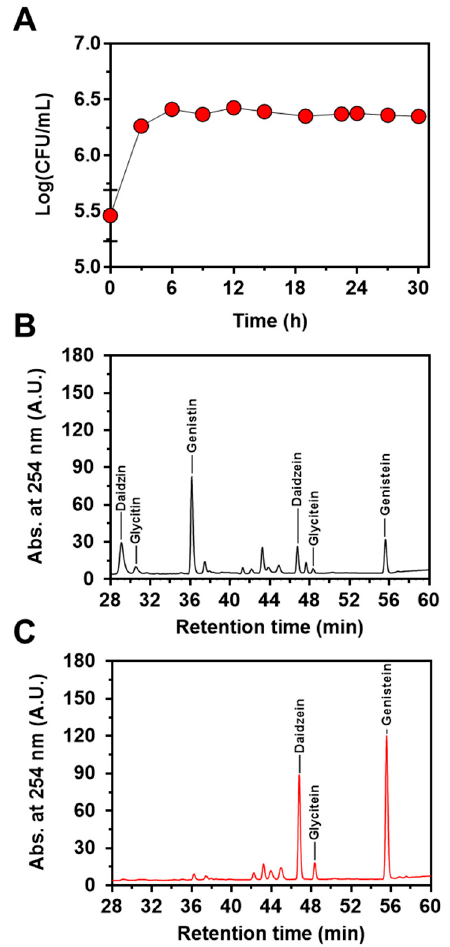
Figure 5. Soymilk fermentation of L. citreum harboring pCB4270V4-IH. ( A ) Growth profiles of L. citreum harboring pCB4270V4-IH. Results are the mean of duplicate experiments, and error bars indicate standard deviations. Chromatogram of HPLC analysis of isoflavones in soymilk during soymilk fermentation at ( B ) 0 h and ( C ) 30 h. Table 2. Summary of isoflavone aglycone forms production with soymilk fermentation.